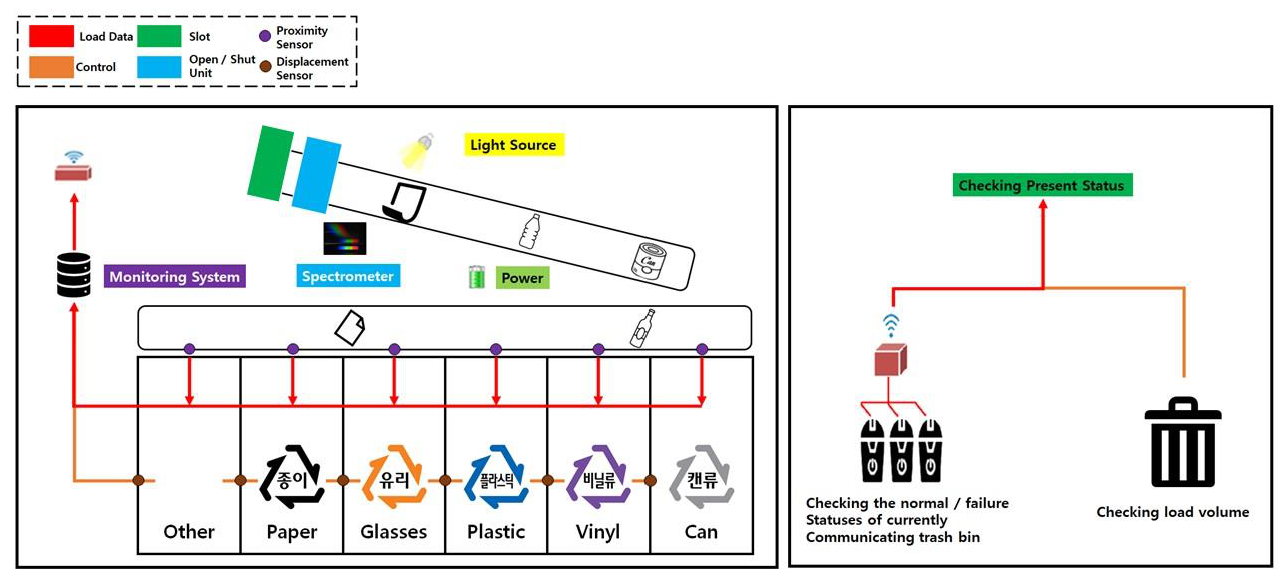
Figure 2. A design of the Smart Trash Bin.